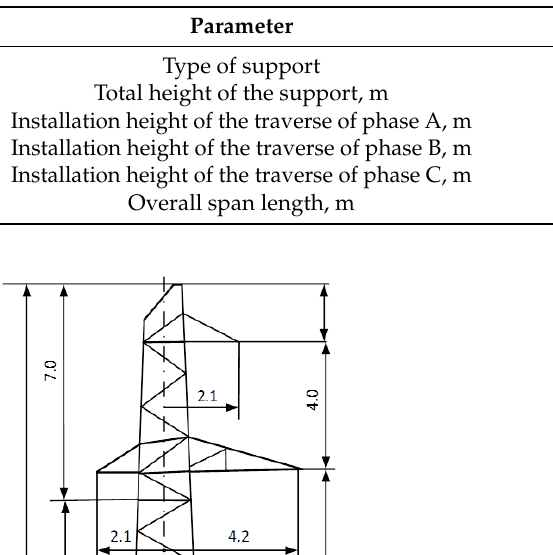
Table 6. Structural dimensions and characteristics of the support.